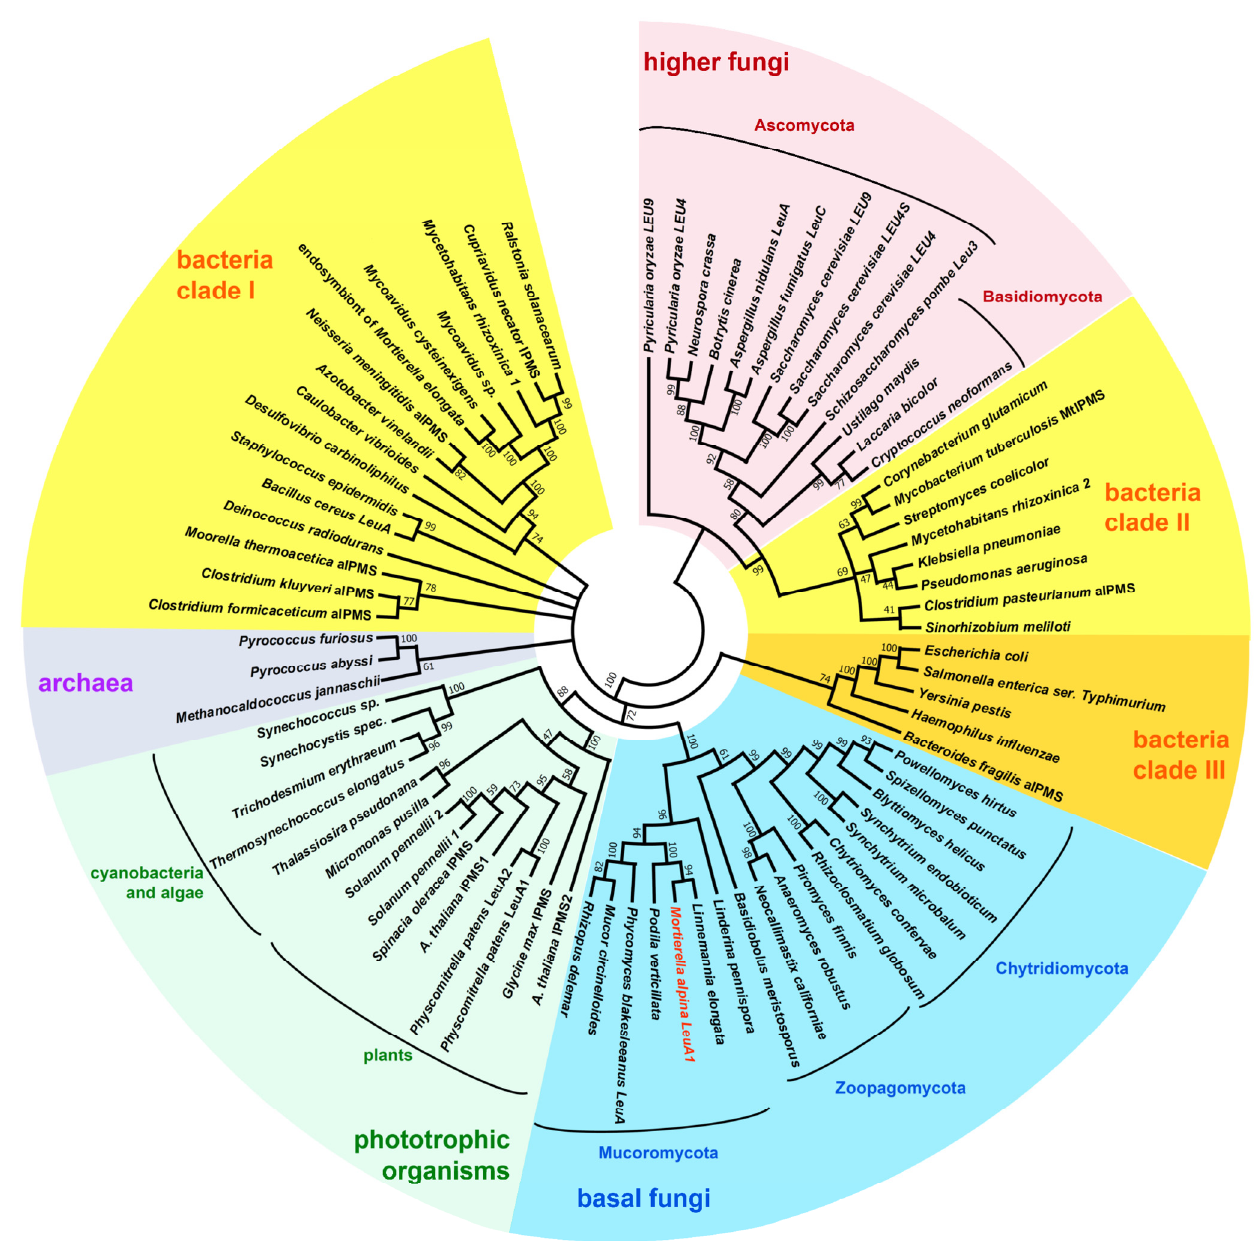
Figure 2. Phylogenetic analysis of IPMS enzymes from various species. The evolutionary history was inferred by using the Maximum Likelihood method and Le Gascuel 2008 model [29]. The percentage of trees in which the associated taxa clustered together is shown next to the branches. Initial tree(s) for the heuristic search were obtained automatically by applying Neighbor–Join and BioNJ algorithms to a matrix of pairwise distances, estimated using the JTT model, and then selecting the topology with superior log likelihood value. A discrete Gamma distribution was used to model evolutionary rate differences among sites (5 categories (+G, parameter = 2.0850)). The rate variation model allowed for some sites to be evolutionarily invariable ([+I], 2.39% sites). Evolutionary analyses were conducted in MEGA11 [30]. Note that basal fungi and higher fungi comprise a divergent phylogenetic origin. The M. alpina LeuA1 is highlighted in red. Enzymes that have been biochemically or genetically verified are indicated with their names. Other proteins are predicted. The accession numbers of the 77 analysed protein sequences are listed in Table